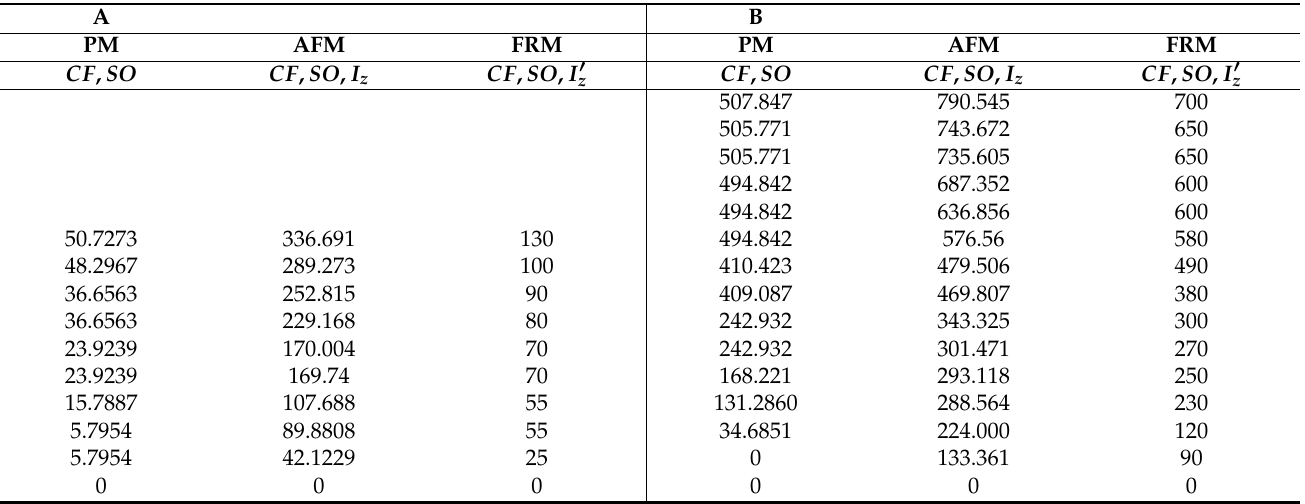
Figure 1. The direction of spins in each Fe 2 + sublattice (A—FeO 4 , B—FeO 6 ) in the AFM and FRM phases, plotted according to [1]. Red (long) arrows indicate the direction of the magnetic moment µ of each sublattice. I z , I (cid:48) z —projections of molecular fields acting on iron ions in AFM and FRM phases, respectively. The short purple arrows show the directions of the calculated dipole moments. P ionic —direction of the calculated ionic polarization vector of the lattice described in Section 4.2. Table 2. The calculated energy levels. In each section, the 1st column corresponds to the energy splitting of the main term of Fe 2 + by the crystal field (CF) of a distorted tetrahedron/octahedron, and spin–orbit interaction (SO), 2nd and 3rd—estimated energy levels in the AFM and FRM corre- spondingly in the presence of the molecular field I z